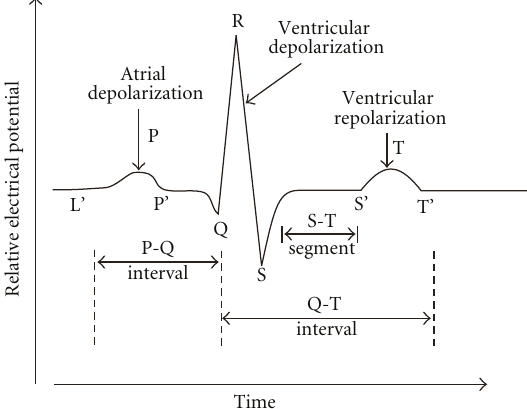
Figure 7: Fiducial features in the